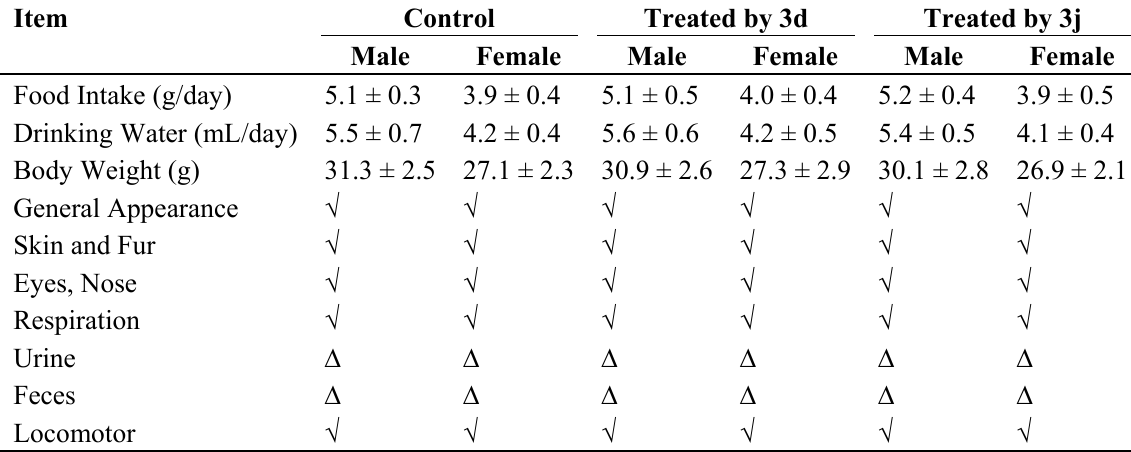
Table 2. Observation of acute toxicity in mice for compound 3d